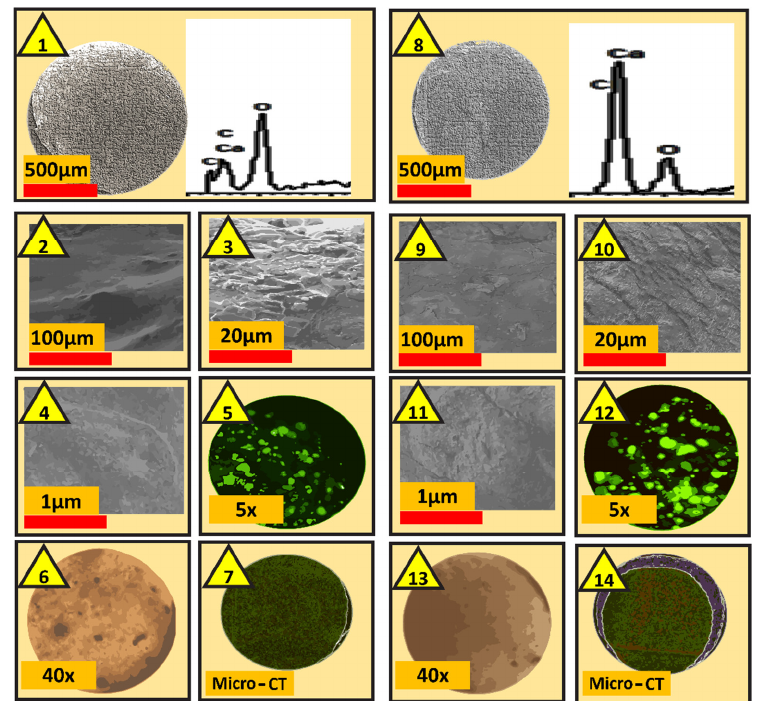
Figure 3. Imaging and surface composition of control (no PB; 1–7) and treatment (with PB; 8–14) microcapsules. Images 1–4 and 8–11 are SEM and EDXR, while images 5 and 12 are confocal. Images 6 and 13 are optical while images 7 and 14 are Micro-CT.